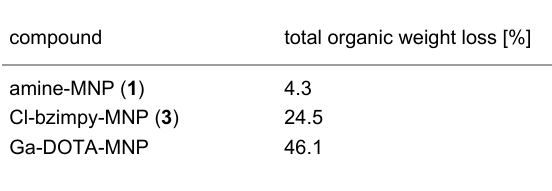
Table 2: Comparison of weight loss during the TG/DTA measurement.